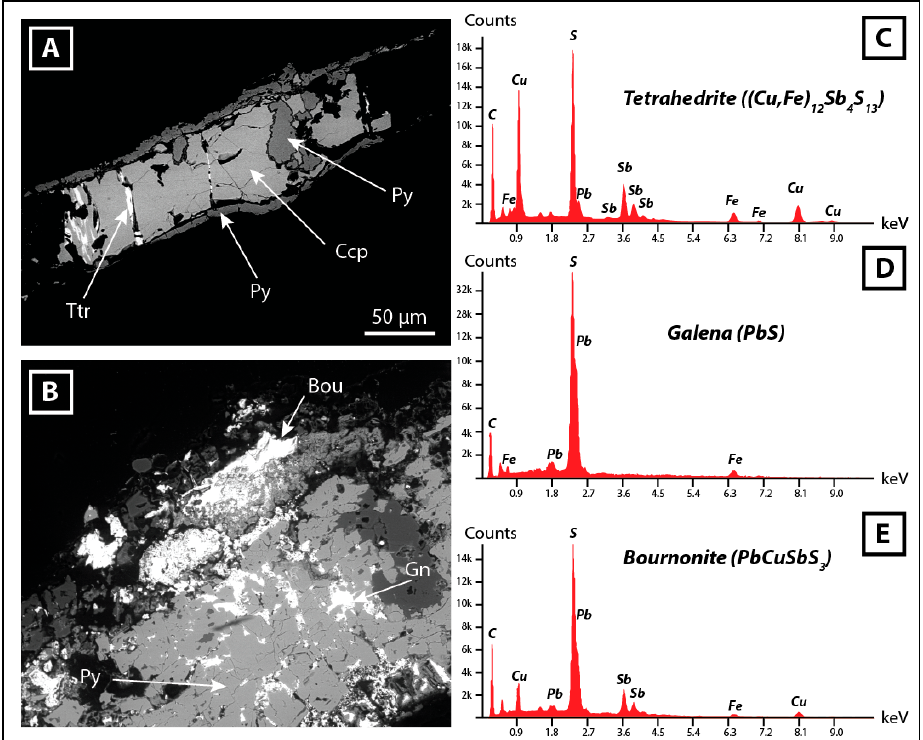
Figure 3. ( A , B ): SEM-BSE images of metal bearing sulfides within a shale fragment from the foot of the tailing. Dark grey minerals are silicates (quartz, feldspars, micas) from the shales. ( C – E ): EDS spectra of selected sulfide minerals. Abbreviations: Bou: bournonite, Ccp: chalcopyrite, Gn: galena, Py: pyrite, Ttr: tetrahedrite.